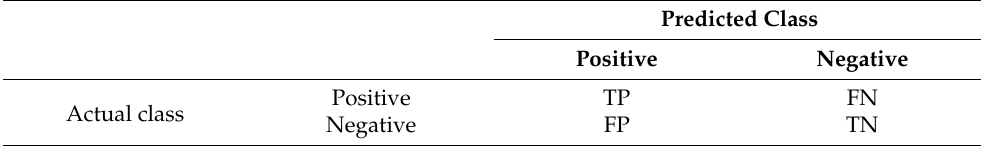
Table 3. Confusion matrix for two types of discriminant